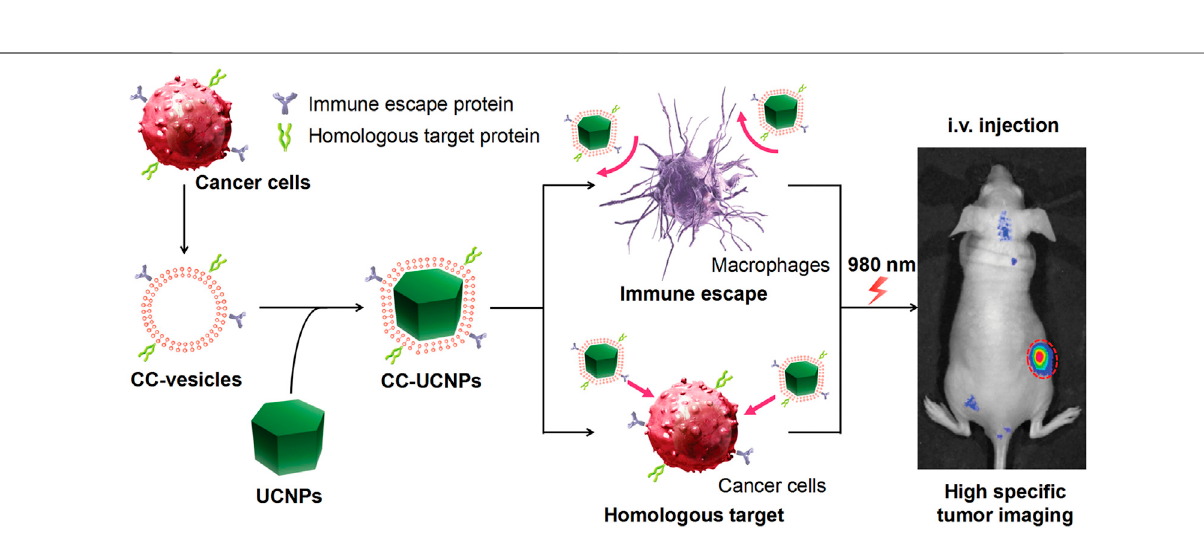
Frontiers in Bioengineering and Biotechnology |